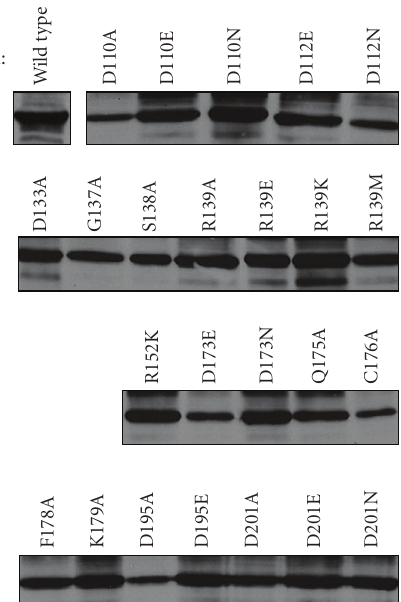
Figure 7: Expression levels of the various versions of CBD-AglD. Hfx. volcanii cells expressing the various AglD mutants considered in this study were grown to OD 550 1.0 and their protein contents were separated on 10% SDS-PAGE. The CBD-AglD content of each strain was subsequently assessed by immunoblot using polyclonal antiCBD antibodies. Antibody binding was detected using HRP- conjugated secondary antibodies and an enhanced chemilumines- cence